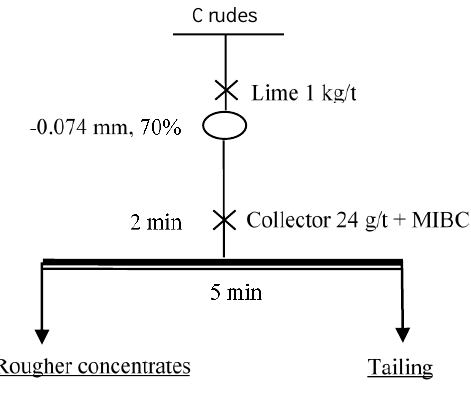
Figure 2. The flow sheet of rougher flotation for chalcopyrite.